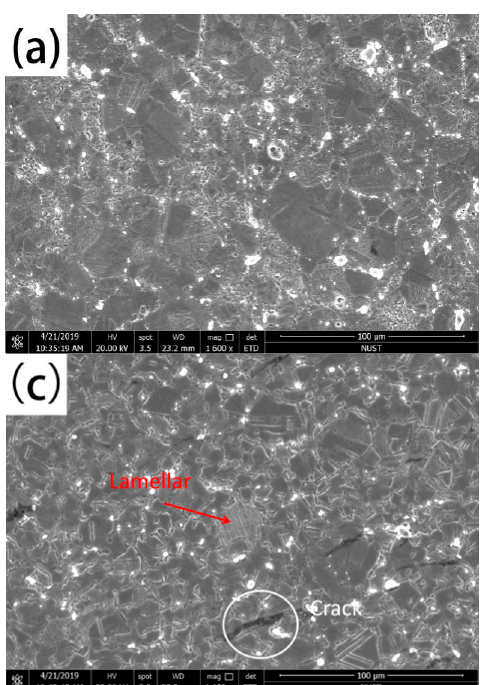
Figure 9. Microstructure of Ti-48Al-2Cr-8Nb alloy prepared by the SP powder with different